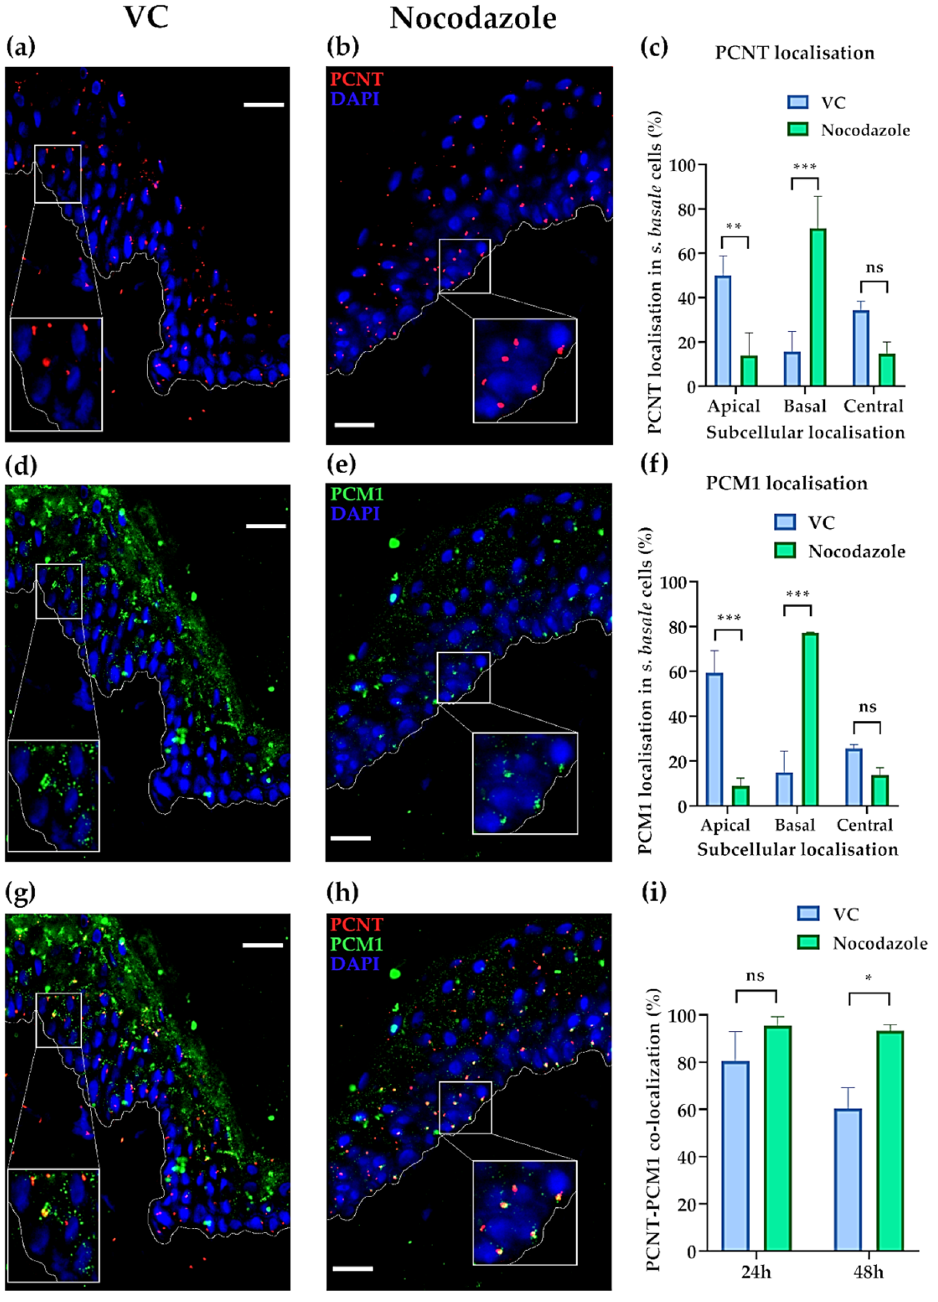
Figure 3. Microtubule depolymerisation (after nocodazole treatment) affects the subcellular localisation of the centrosome (PCNT) and centriolar satellites (PCM1) in S. basale KCs in human skin ex vivo. ( a ) Localisation of the centrosome (red) in VC- and ( b ) nocodazole-treated ex vivo skin after 24 h in culture. ( c ) Quantification of subcellular localisation of centrosome. Graph shows the percentage (%) of S. basale KCs with apical, basal and central PCNT localisation. ** indicates p -value < 0.01, *** indicates p -value < 0.001 and ns indicates not significant in a two-way ANOVA test ( n = 3 donors; 33–55 PCNT dots/replicate). ( d ) Localisation of centriolar satellites (green) in VC- and ( e ) nocodazole-treated ex vivo skin after 24 h in culture. ( f ) Quantification of centriolar satellite localisation. Graph shows the percentage (%) of PCM1 satellite clouds with apical, basal and central localisation. *** indicates p -value < 0.001 and ns indicates not significant in a two-way ANOVA test (n = 3 donors, 25–45 PCM1 clouds/replicate). ( g ) Co-localisation (orange/yellow) of centrosome (PCNT, red) and centriolar satellites (PCM1, green) in VC- and ( h ) nocodazole-treated ex vivo tissues after 24 h in culture. ( i ) Quantification of centrosome co-localisation with centriolar satellites. Graph shows the percentage (%) of co-localisation in S. basale KCs. * indicates p -value < 0.05, ns indicates not significant using one-way ANOVA ( n = 3 donors, 22–60 cells/replicate).